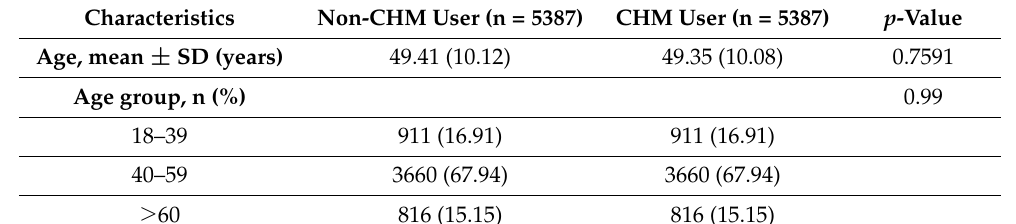
Table 1. Baseline characteristics of breast cancer